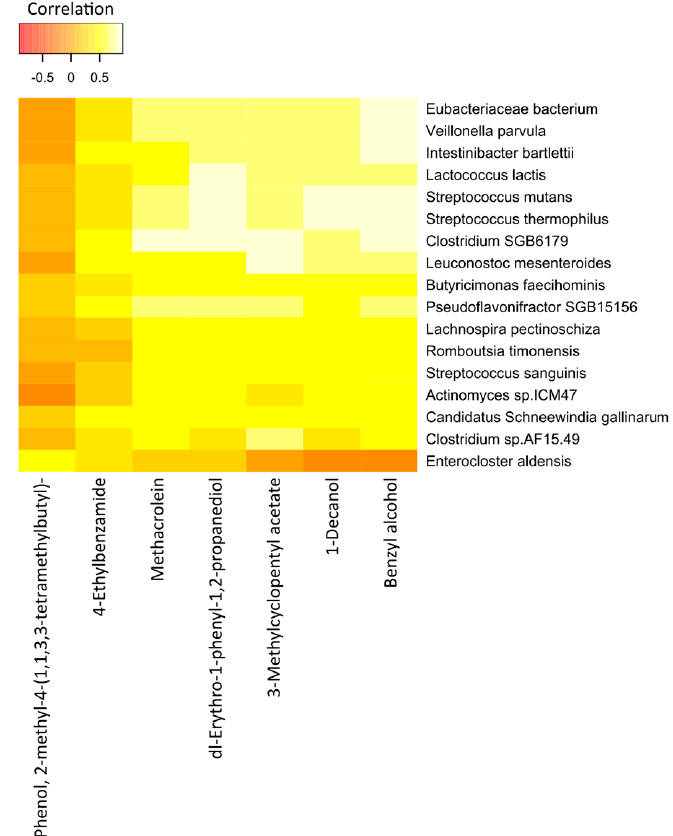
Figure 8. Correlation heatmap of the 7 VOCs and 17 fecal bacterial species in healthy controls. Red color indicates negative correlations, and white or light yellow color indicates positive correlations. The quantitative color scheme is shown at the top.